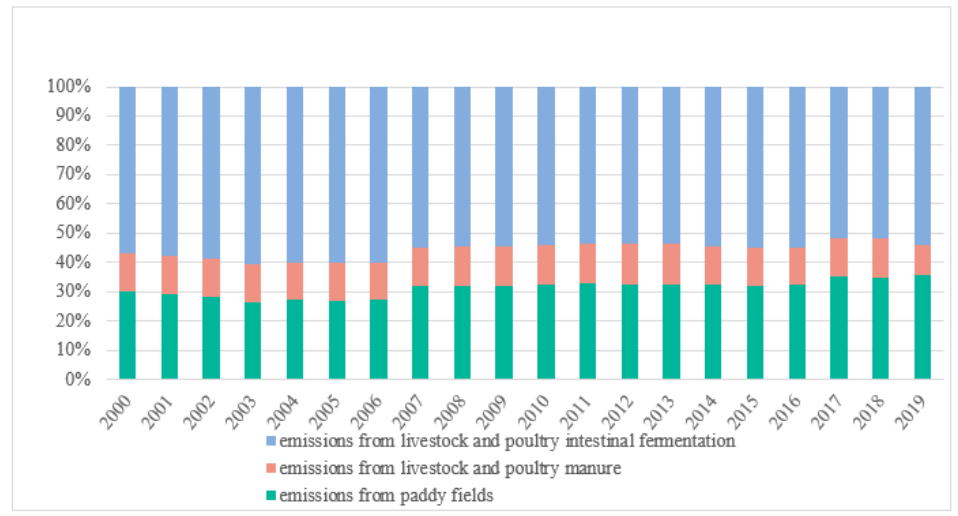
Figure 2. Agricultural methane emissions percentage in China, 2000–2019.